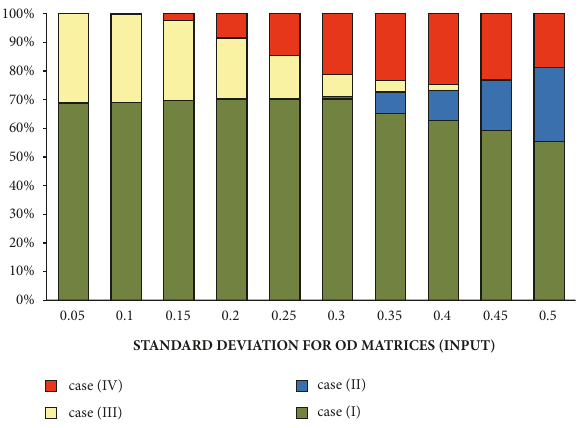
Figure 9: The predicted uncertainty for the link No. 6, applying lognormal distribution scenarios [27].